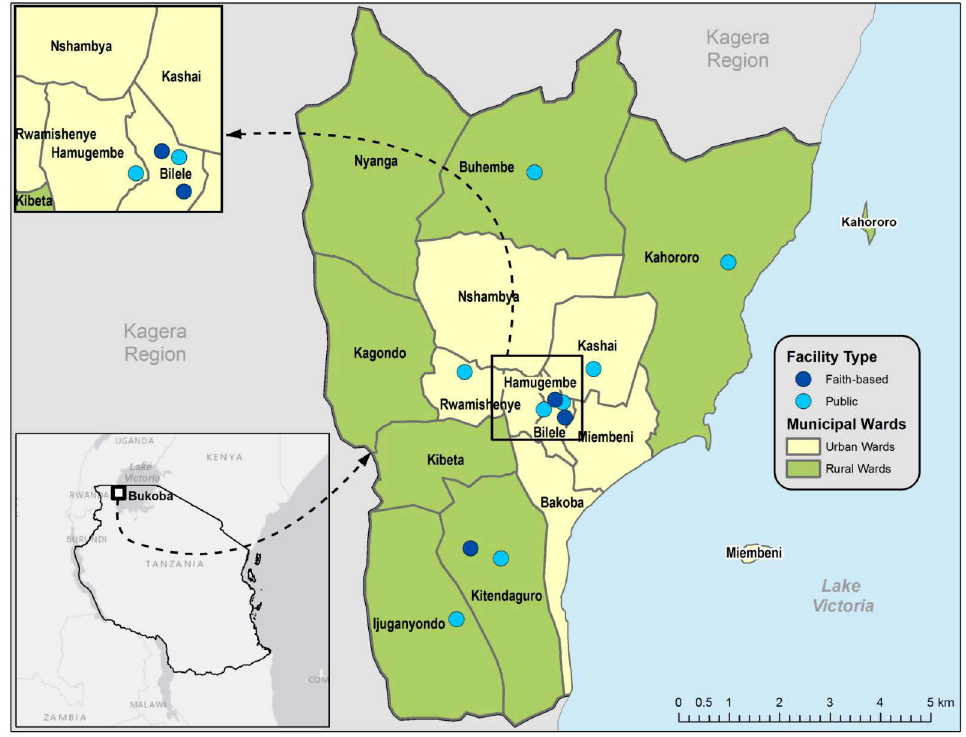
Fig 1. Map of Bukoba Municipal Council, Kagera Region, Tanzania. a a Estimated population in 2017 = 150,867. Bukoba Municipal Council is a geographic district within Kagera Region. Provider initiated HIV testing and counseling was implemented in 11 faith-based and government healthcare